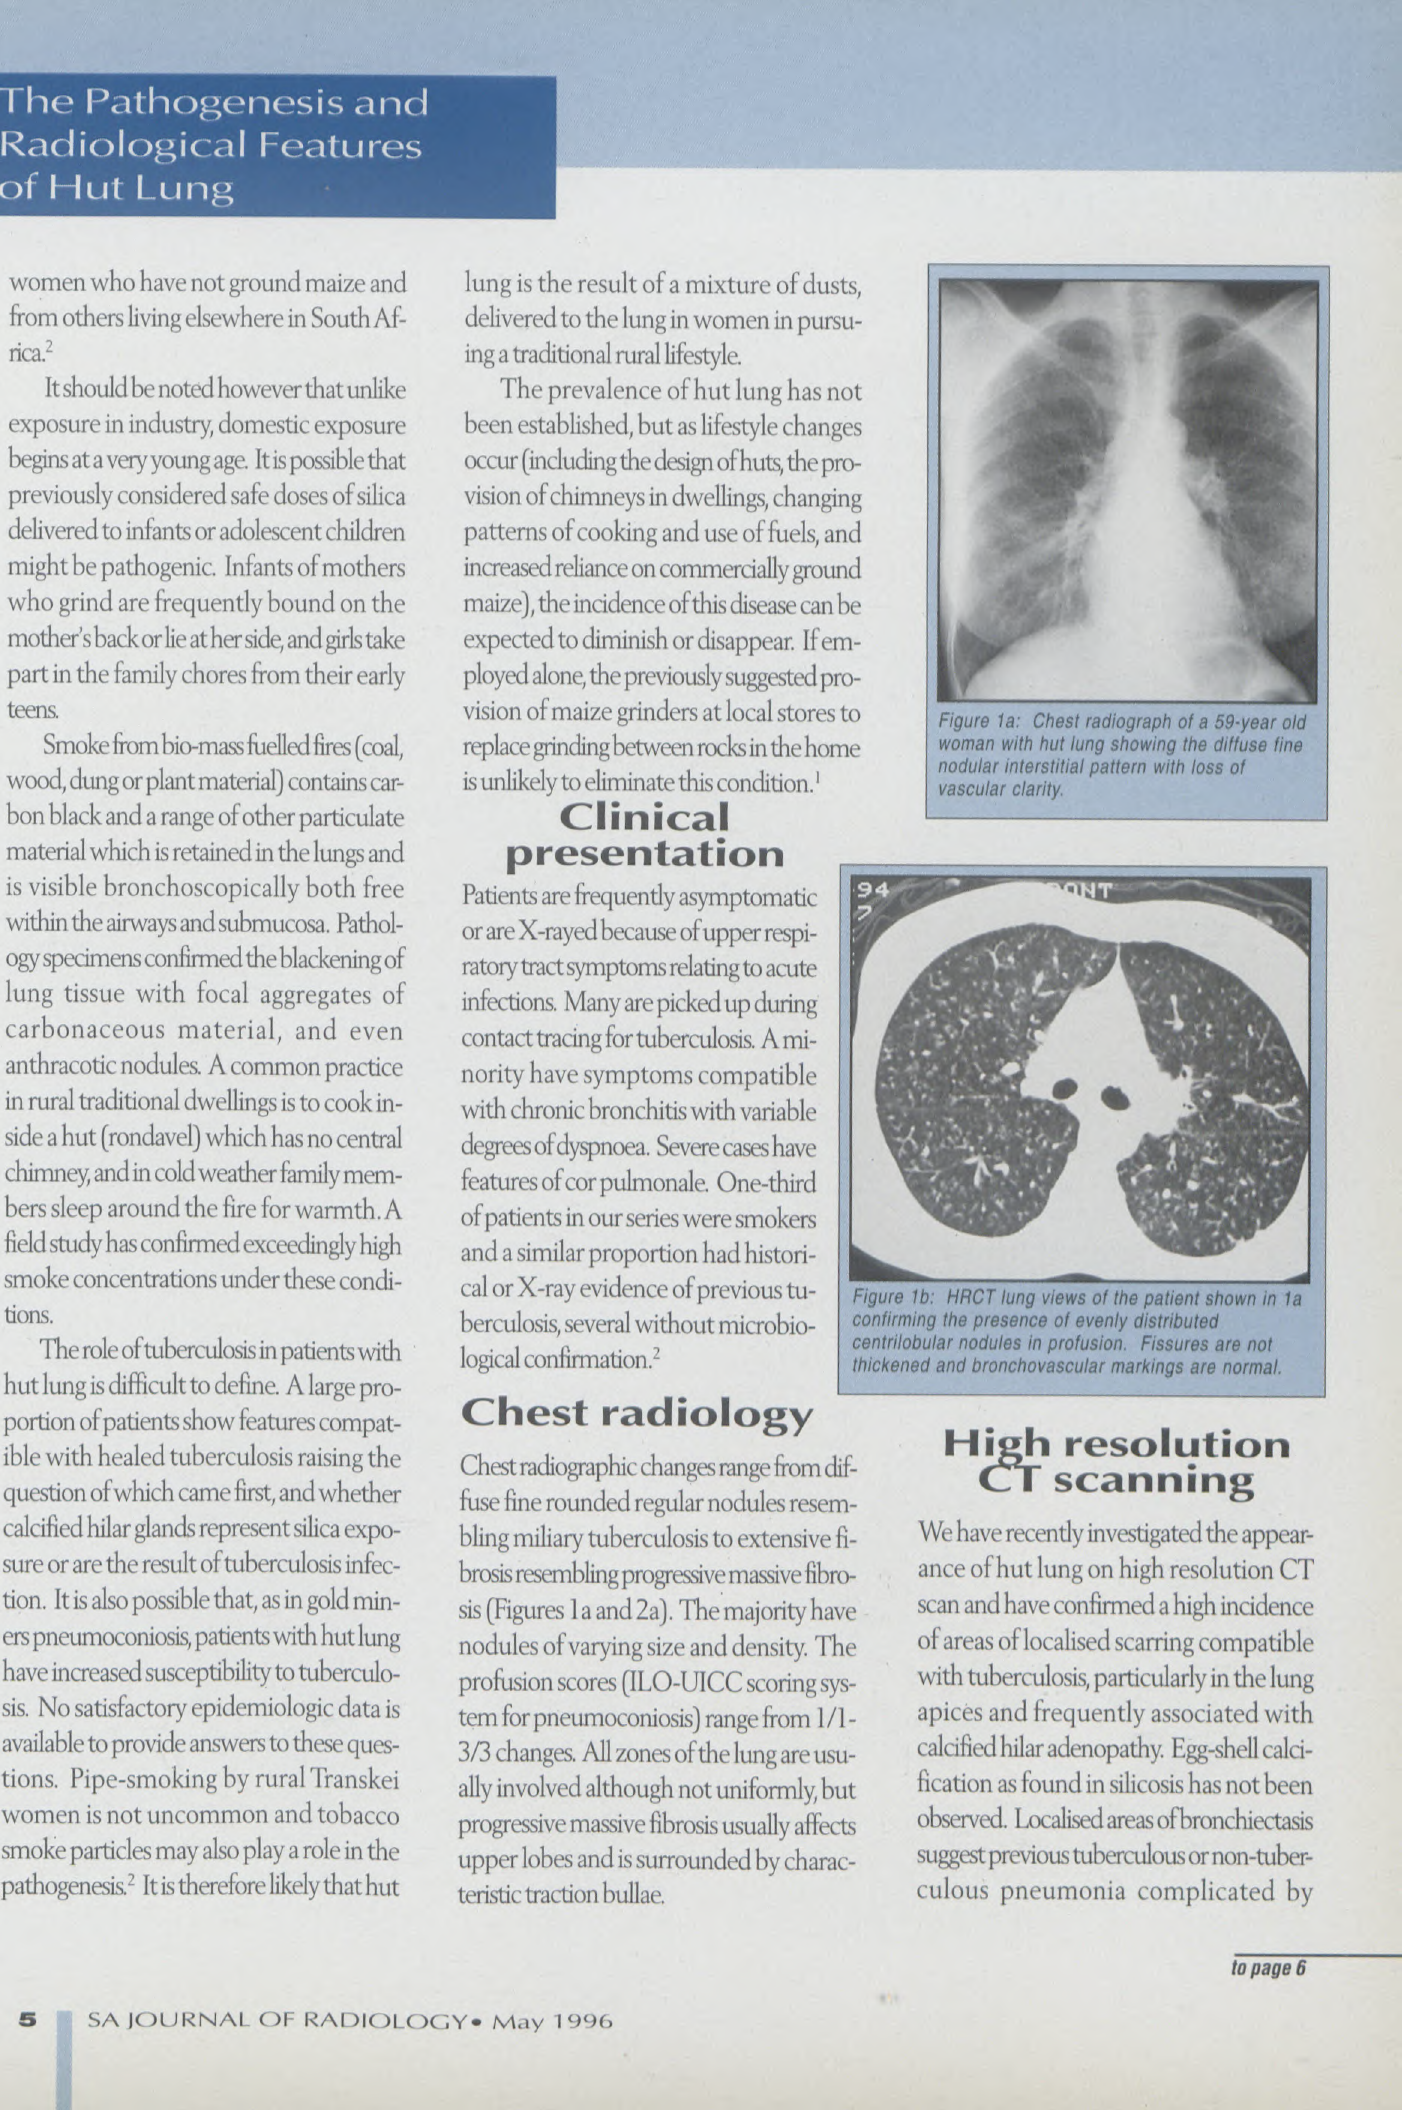
Figure la: Chest radiograph of Il 59-year old woman with hut lung showing the diffuse fine nodular interstitial patlem with loss of vascular clarity.